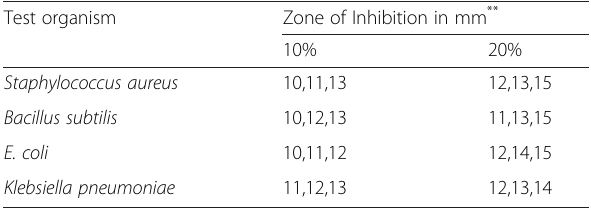
Table 2 Results of antibacterial activity of herbal lotion by agar well diffusion method